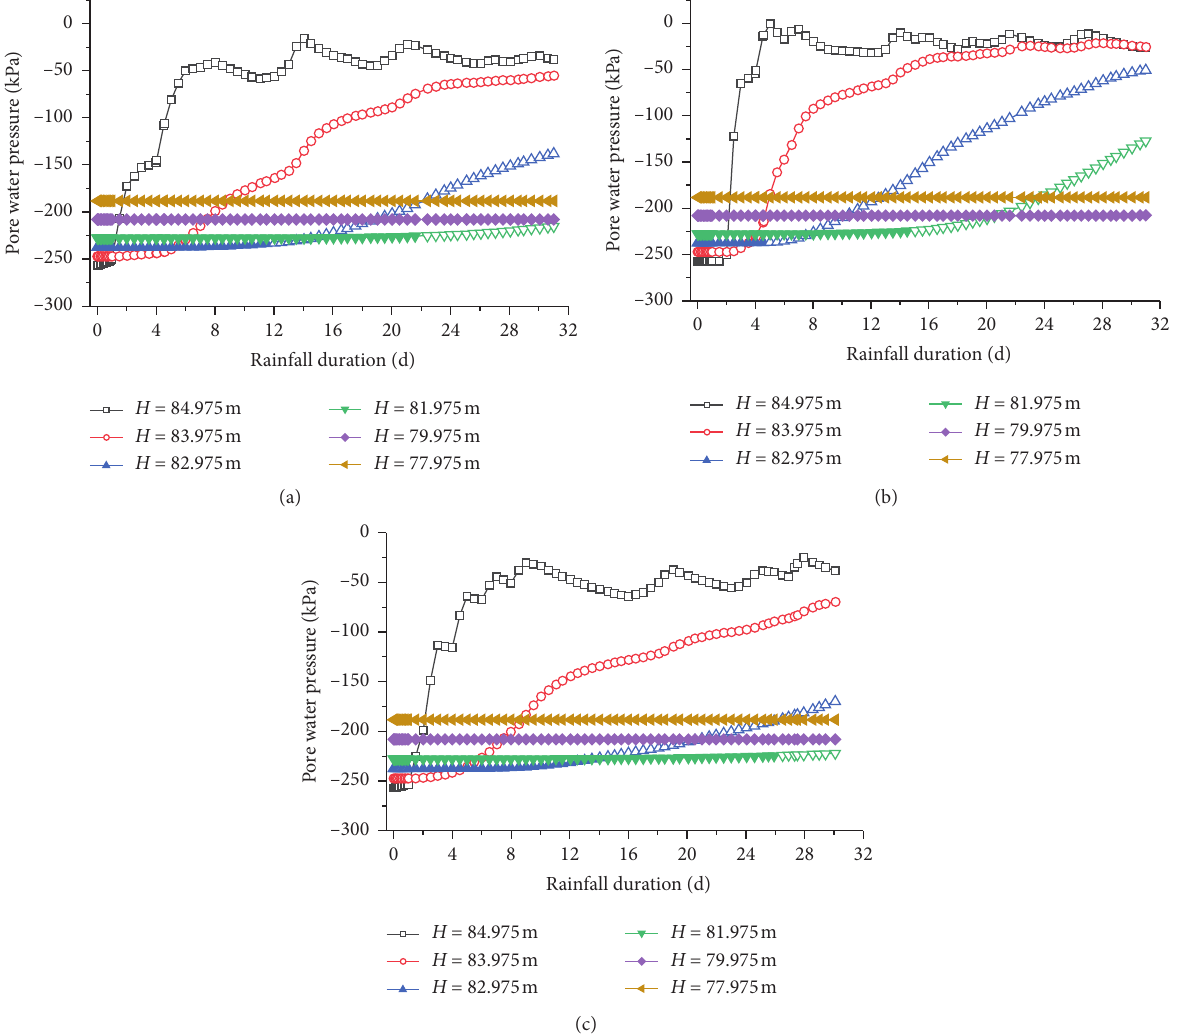
Figure 9: Pore water pressure distribution of monitor points in the slope under the rainfall pattern of (a) single-peak; (b) wave; (c)